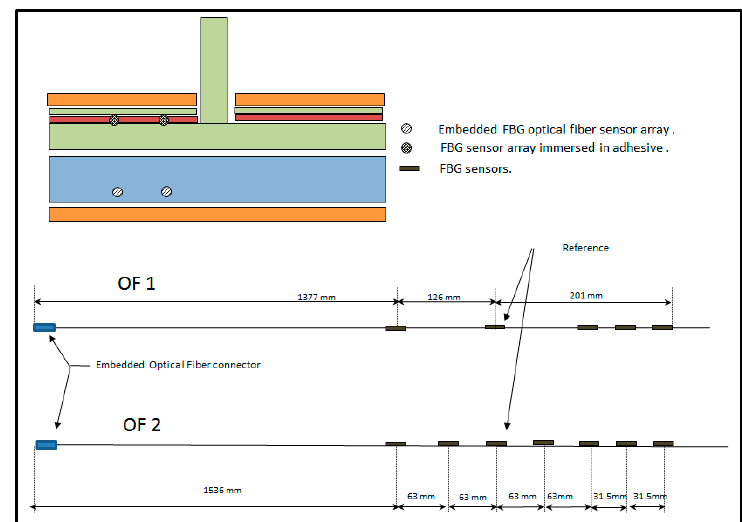
Figure 3. FBG arrays configurations and locations.